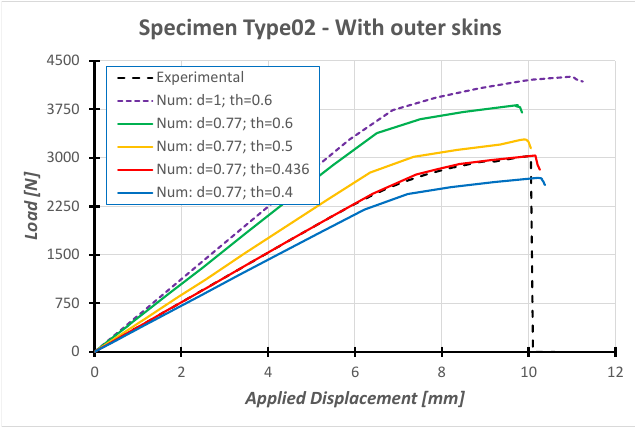
Figure 15. Reaction load vs. applied displacement for specimens Type02.